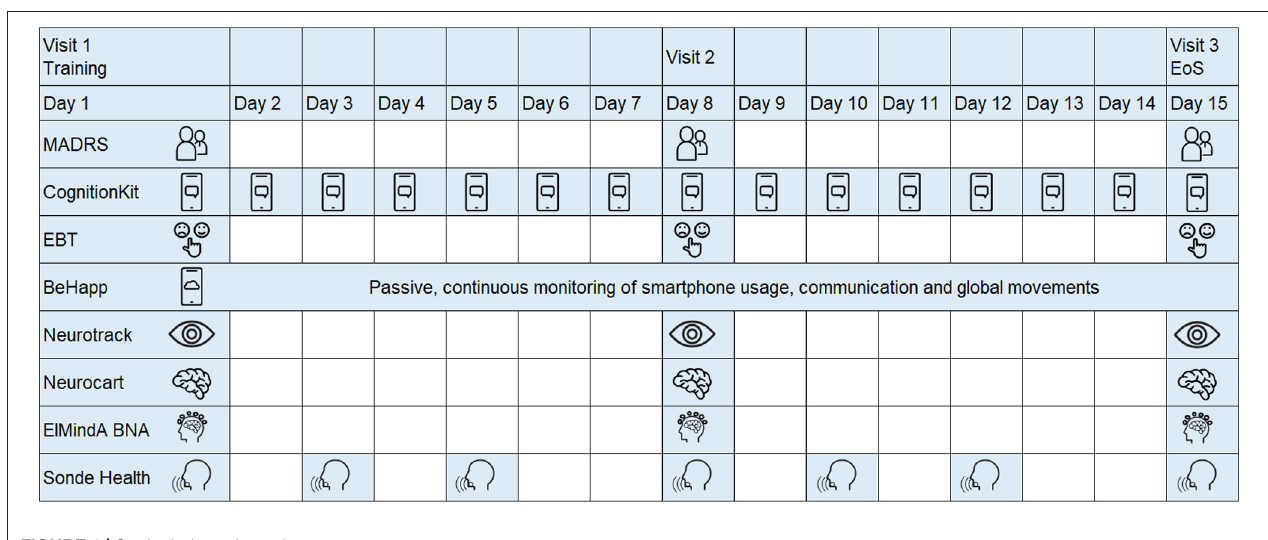
FIGURE 1 | Study design schematic.